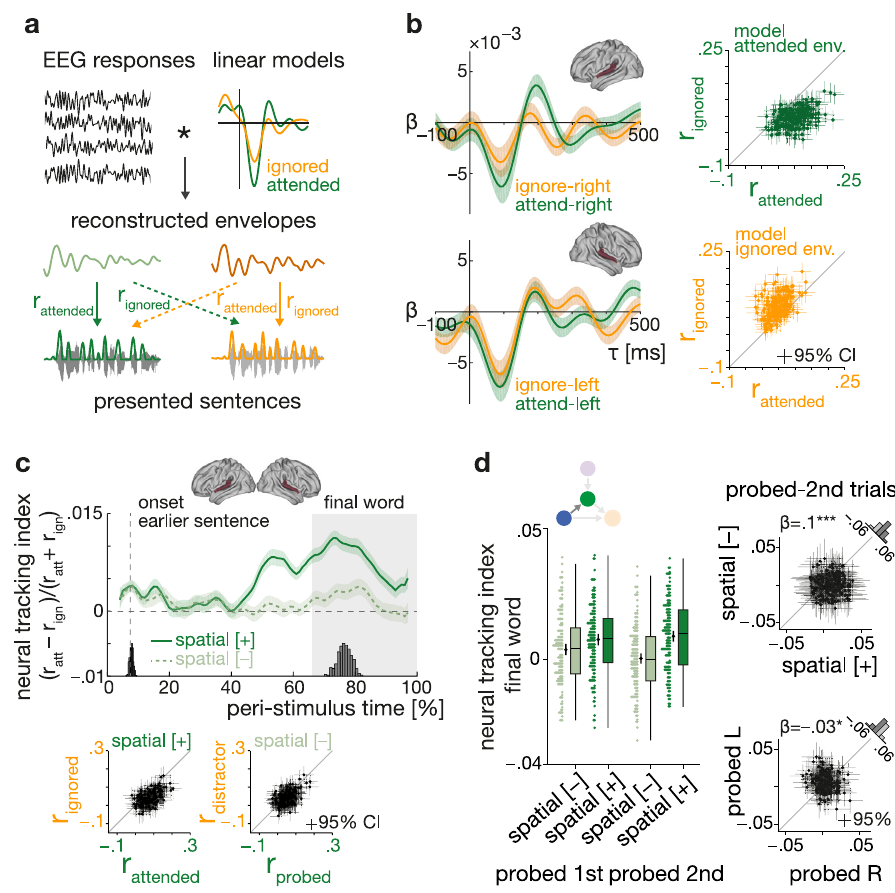
Fig. 4 Neural speech tracking of attended and ignored sentences. a Schematic representation of linear backward model approach. Linear backward models estimated on selective-attention trials. Onset envelopes are reconstructed via convolution of auditory EEG responses with estimated backward models and compared actual envelopes to assess neural tracking strength and decoding accuracy (see Supplementary Methods). b Left: grand-average ( N = 155 participants, 95% con fi dence interval (CI) error bands) forward-transformed temporal response functions (TRFs) for attended (green) and ignored (yellow) speech in the left and right auditory ROI. Right: single-subject ( N = 155 participants; 95% CI error bars) mean Pearson correlation of reconstructed and presented envelopes shown separately for attended (top, green) and ignored speech (bottom, yellow). c Top: grand-average ( N = 155 participants) peri-stimulus time course of neural tracking index shown separately for selective (solid dark green curve) and divided attention (dashed light- green curve) ±1 SEM error band. Histograms show sentence and fi nal-word onsets. The shaded area indicates the fi nal-word presentation interval used for statistical analysis. Bottom: Single-subject ( N = 155 participants) mean attended and ignored neural speech tracking during fi nal-word presentation for selective and divided attention, respectively. d Left: neural tracking index shows per spatial-attention condition and for trials in which cued/probed sentences started ahead of ( ‘ probed fi rst ’ ) or after the distractor ( ‘ probed second ’ ). Coloured dots represent the single-subject average ( N = 155 participants), black dots and error bars indicate grand-average and bootstrapped 95% CI. Box plots show median centre line, 25th to 75th percentile hinges, whiskers indicate minimum and maximum within 1.5 × interquartile range. Right: signi fi cant difference in neural tracking between selective- and divided-attention trials in probed second trials (top plot), and stronger neural tracking in probed-left trials. Black dots represent the individual mean neural tracking index with bootstrapped 95% CI error bars for N = 155 participants. Histogram shows the distribution of differences in neural tracking in informative vs. uninformative spatial-cue trials, and probed-left vs. probed-right trials, respectively. β : slope parameter estimate from the corresponding general linear mixed-effects model; *** P = 1.22 × 10 − 9 , * P = 0.0233 (two-sided Wald test, FDR-corrected). Source data are provided as a Source Data fi